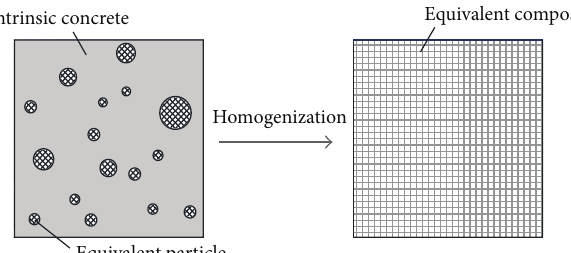
Figure 4: The equivalent composite of repaired concrete reached by the third-level micromechanical homogenization to the two-phase composite consisting of the intrinsic concrete and equivalent